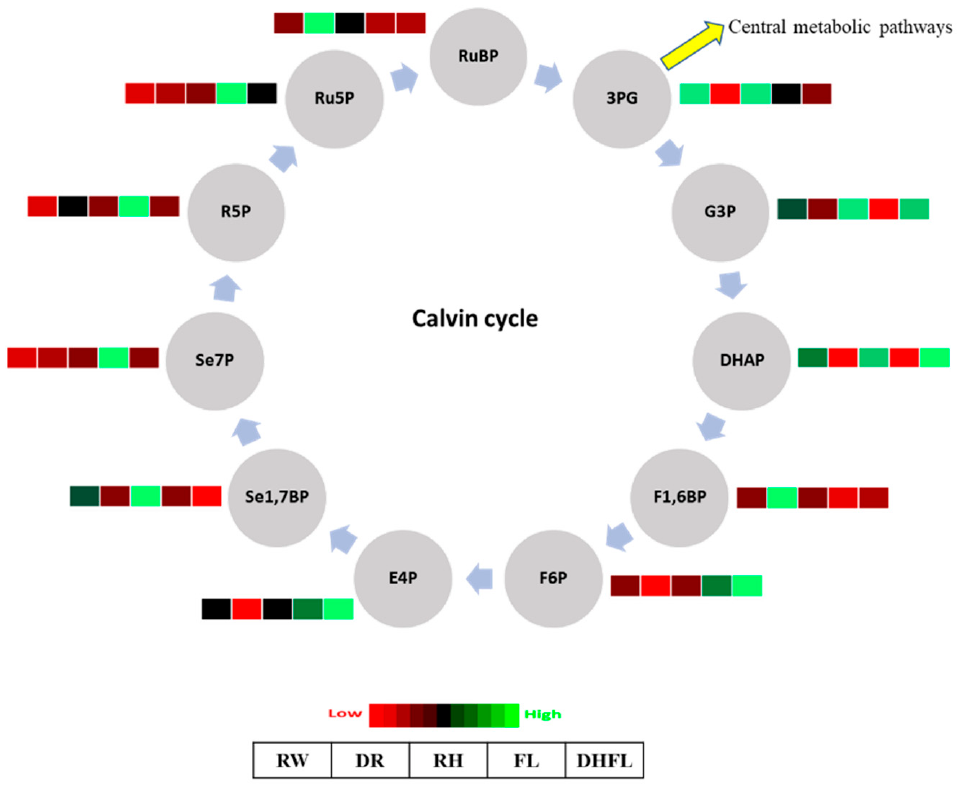
Figure 2. A heat map depicting the individual concentrations of intermediate metabolites of the Calvin cycle in Mexican mint ( Plectranthus amboinicus ) plants under varying watering regimes (n = 3). 3-phosphoglyceric acid (3PG), glyceraldehyde-3-phosphate (G3P), dihydroxyacetone phosphate (DHAP), fructose-1,6-bisphosphate (F1,6BP), fructose-6-phosphate (F6P), erythrose-4-phosphate (E4P), sedoheptulose-1,7-bisphosphate (Se1,7BP), sedoheptulose-7-phosphate (Se7P), ribose-5-phosphate (R5P), ribulose-5-phosphate (Ru5P), and ribulose-1,5-bisphosphate (RuBP). Metabolite concentrations in each block compartment are normalized across all data for an individual compound such that similar color intensities between compounds can represent widely differing concentrations. The red color represents a lower concentration, and the green color represents a higher concentration of a particular metabolite. The compartments were arranged from left to right as follows: regular watering (RW), drought (DR), resumption of regular watering after drought (RH), flooding (FL), and resumption of regular watering after flooding